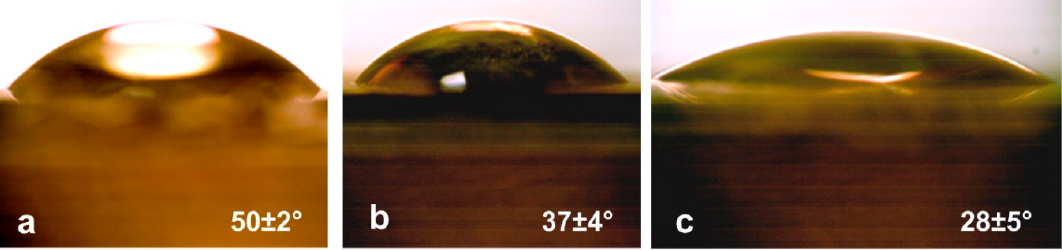
Figure 5. Appearance of ( a ) water droplets on the surface of PET tape, ( b ) PET tape coated with collagen, and ( c ) PET tap coated with SWCNT/collagen.